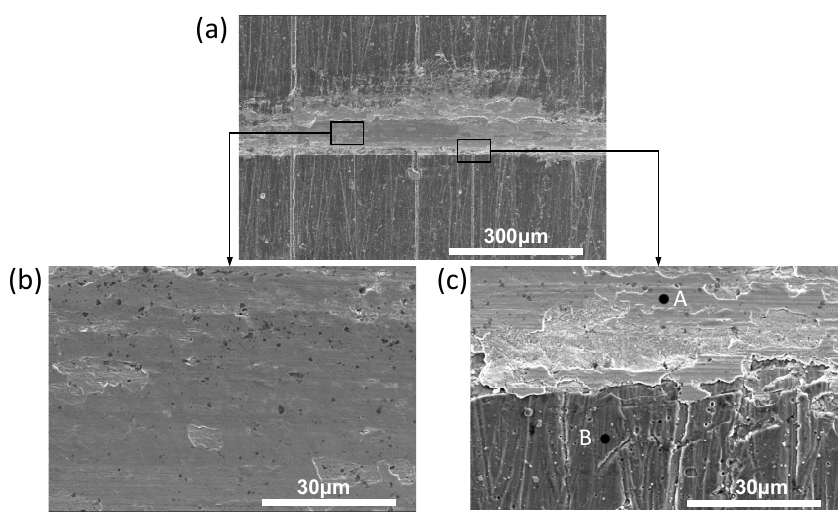
Figure 16. SEM micrographs of the TiCN coating worn surfaces in oil (P = 106 N): ( a ) Macro morphology; ( b ) Central part; ( c ) Edge part.